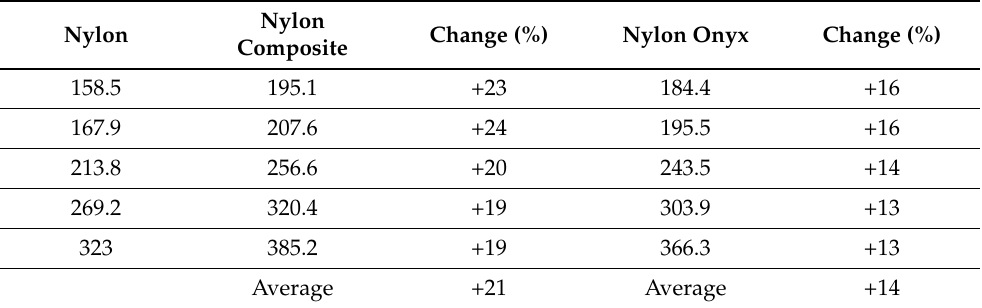
Table 9. First five natural frequencies of re-entrant lattice structure in the free–free boundary condition and the paired modes when the material of vertical parts of honeycomb lattice structure changed to composite or onyx.